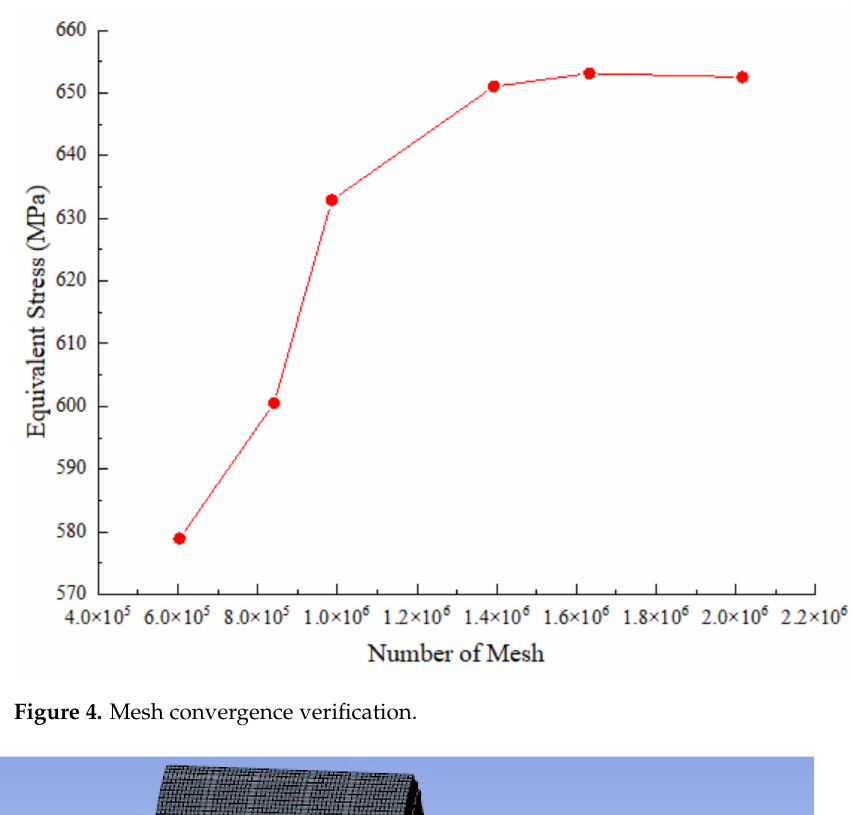
Figure 4. Mesh convergence verification.